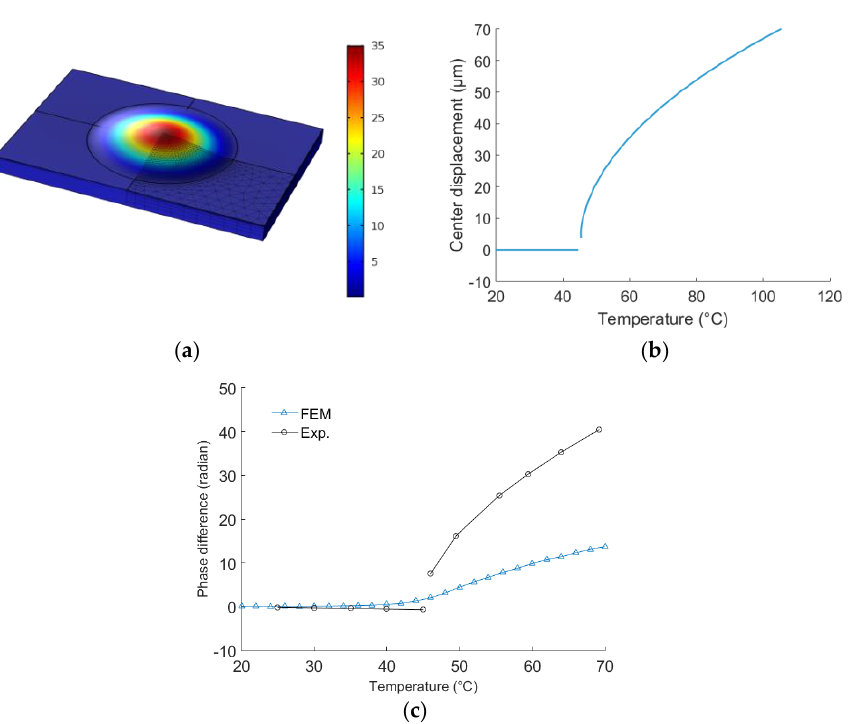
Figure 9. ( a ) Deformed shape of the membrane after buckling, at 60 °C. Only one fourth of the model was used to perform the computations, following the symmetry of the system; ( b ) Displacement vs. temperature, at the center of the membrane; ( c ) Sensor’s phase response vs. temperature, in the complete operating temperature range, including buckling effect.